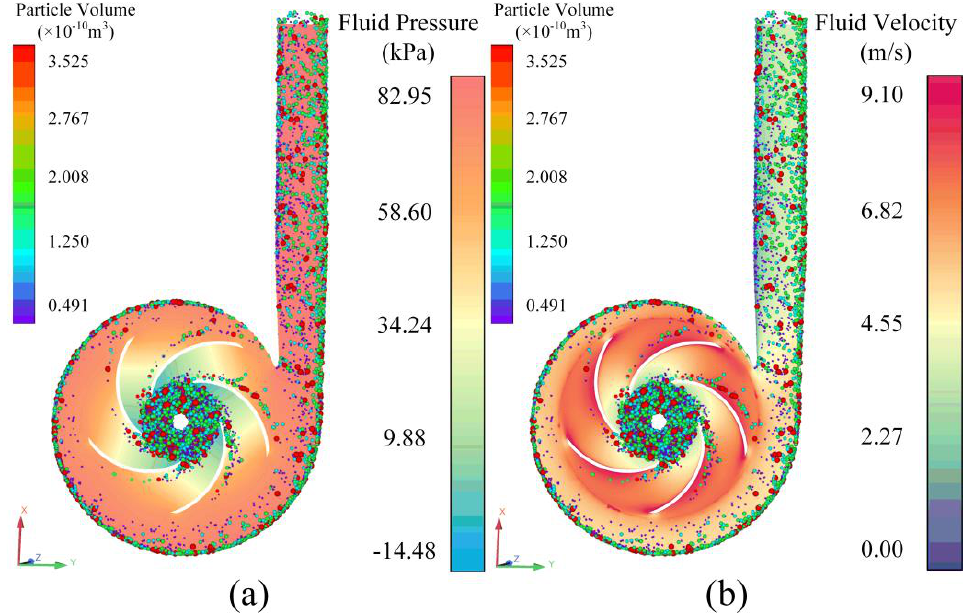
Figure 16. Solid–liquid two-phase characteristics of the centrifugal pump (t = 0.62 s): ( a ) particle–fluid pressure; ( b ) particle–fluid velocity.